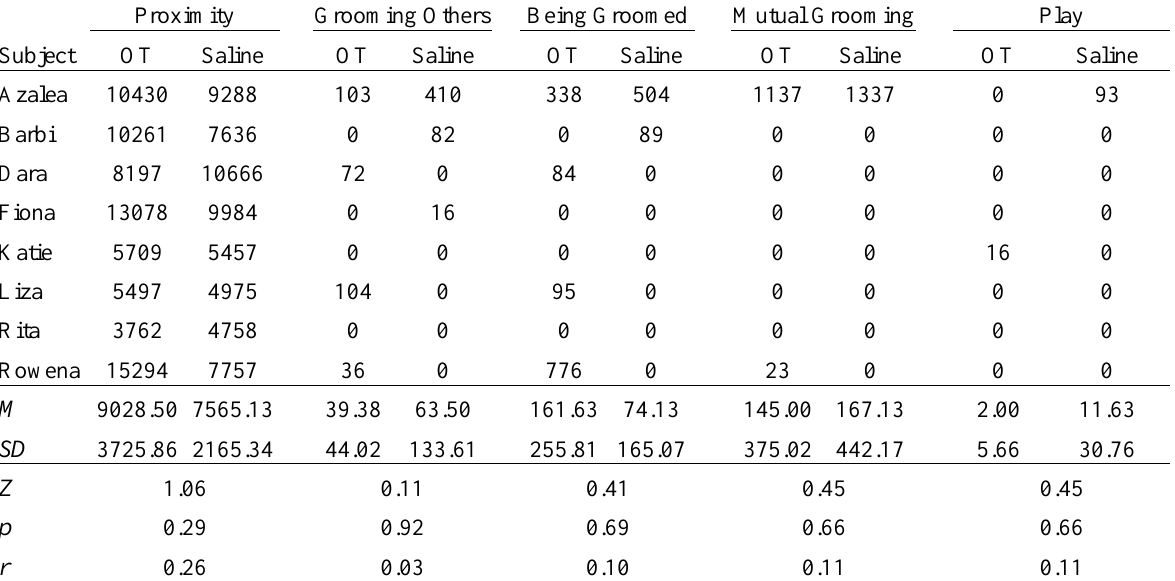
Duration of Behaviors (in Seconds)